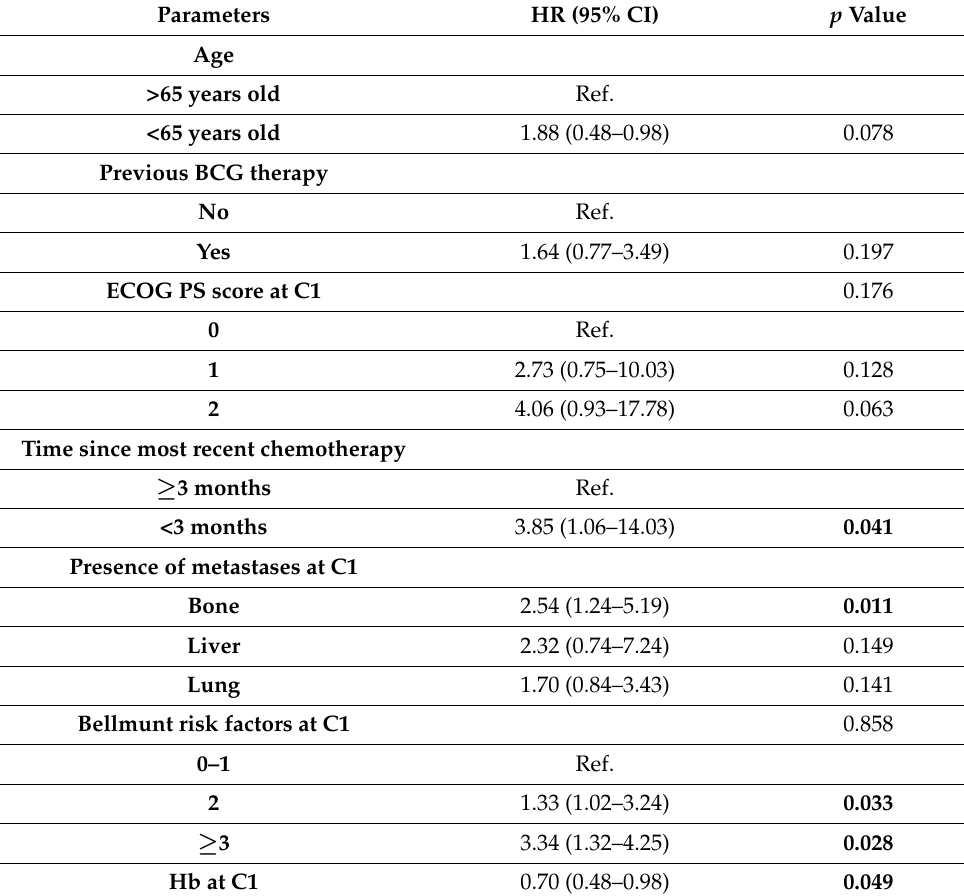
Table 2 . PFS status at 6 months—Multivariate analysis .